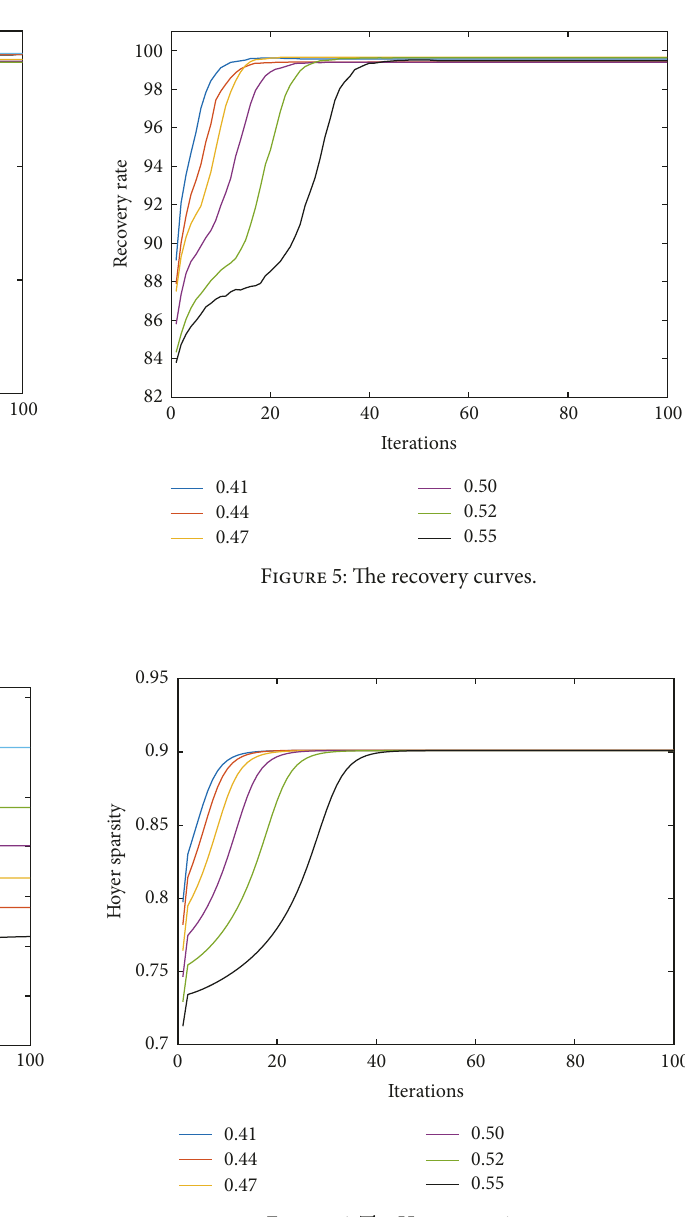
Figure 6: The Hoyer